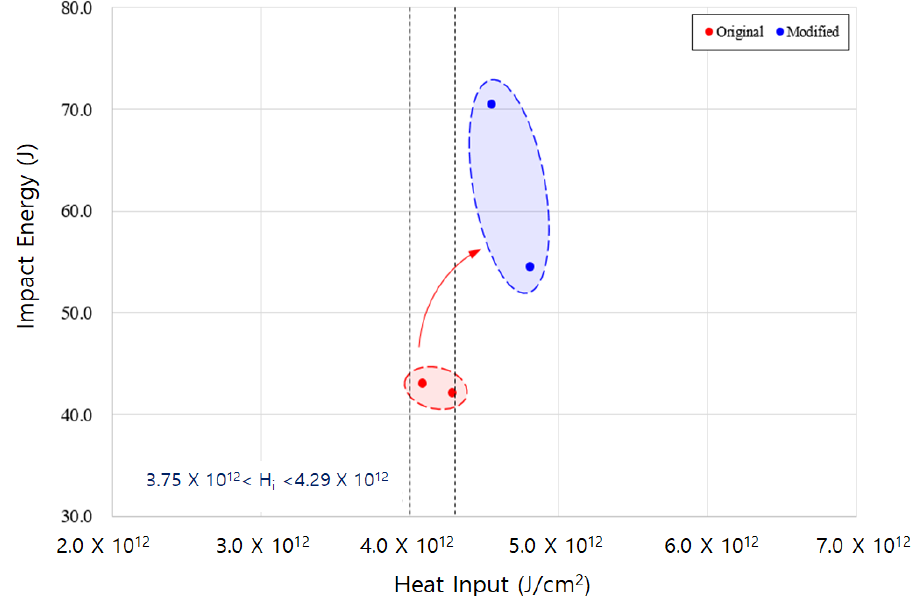
Figure 11. Brittle fracture behavior distributions using modified input parameters.